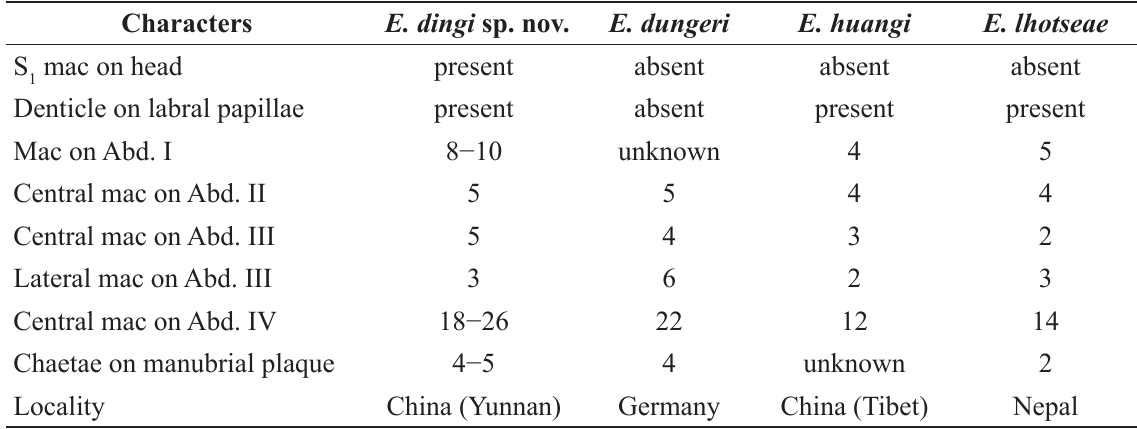
Table 3. Comparison among Entomobrya dingi sp. nov., E. dungeri Jordana, Schulz & Baquero, 2011, E. huangi Chen & Ma, 1998 and E. lhotseae Yosii, 1971